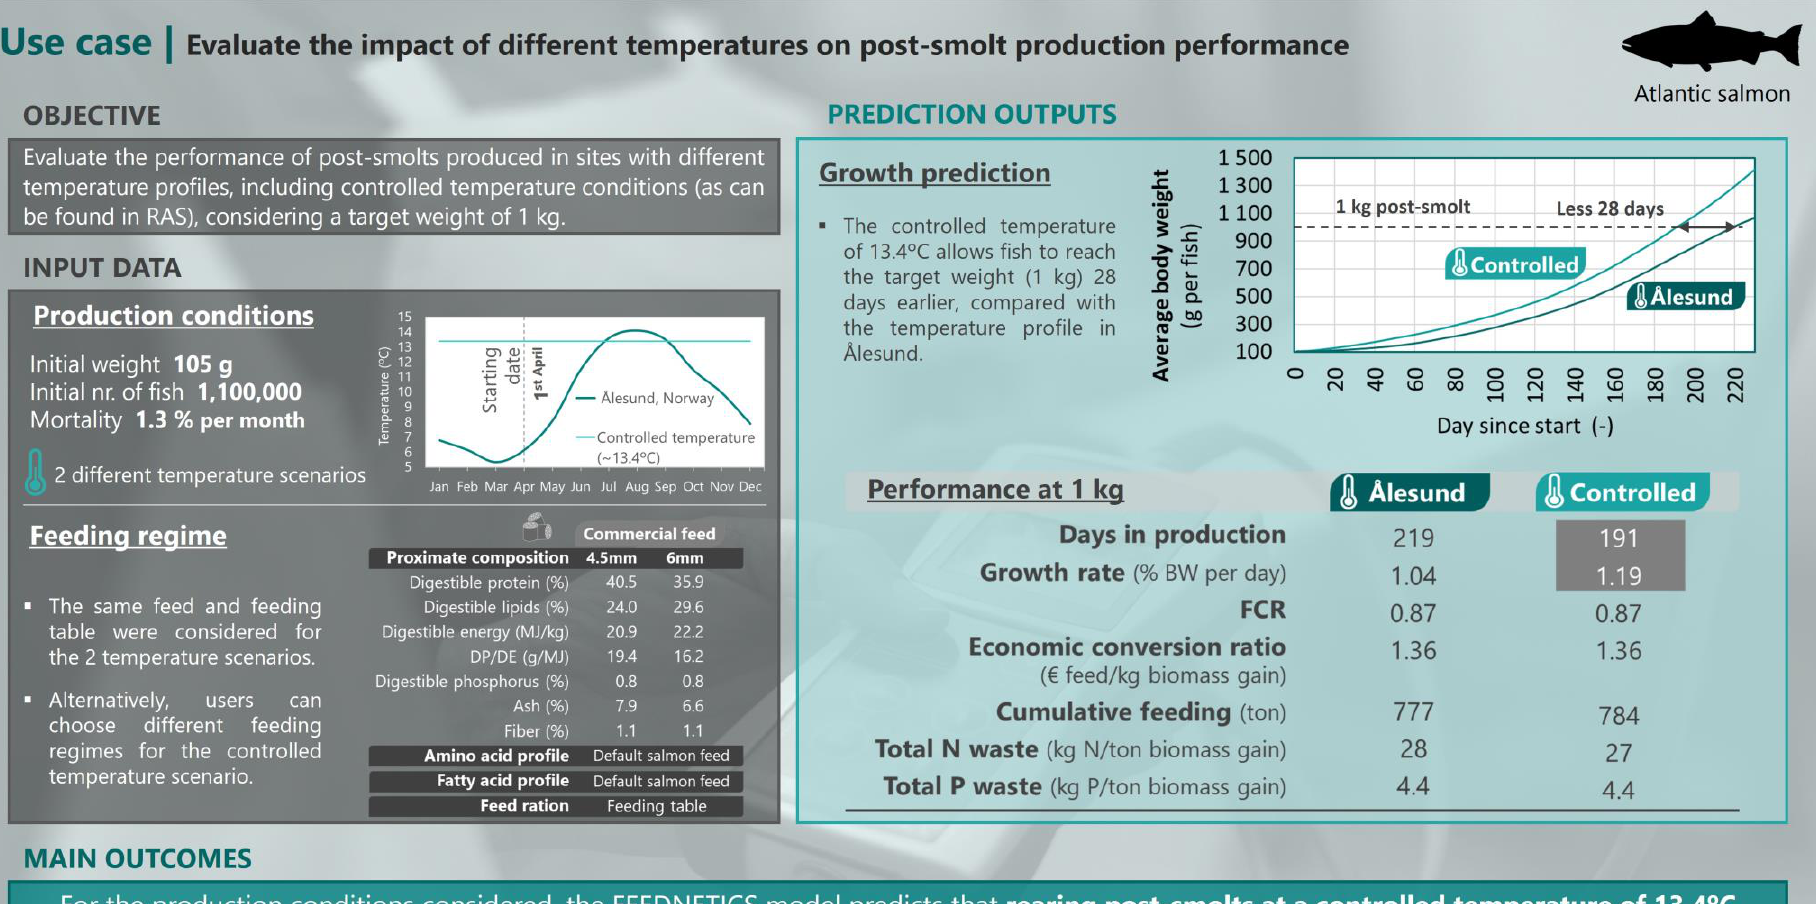
Figure A5. Use case 2: Evaluate the impact of different temperature profiles on post-smolt production performance. All results are model predictions.